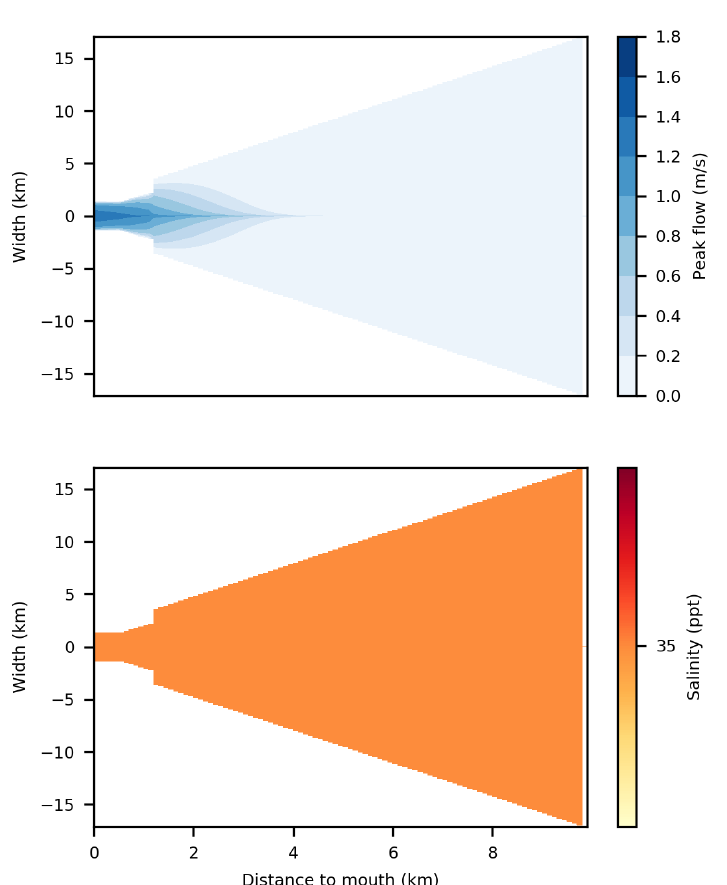
Figure A7. Resulting predictions of bed elevation with respect to the high water level, inundation duration, peak flow velocity and salinity for a tidal basin with dimensions based on the Ameland inlet.